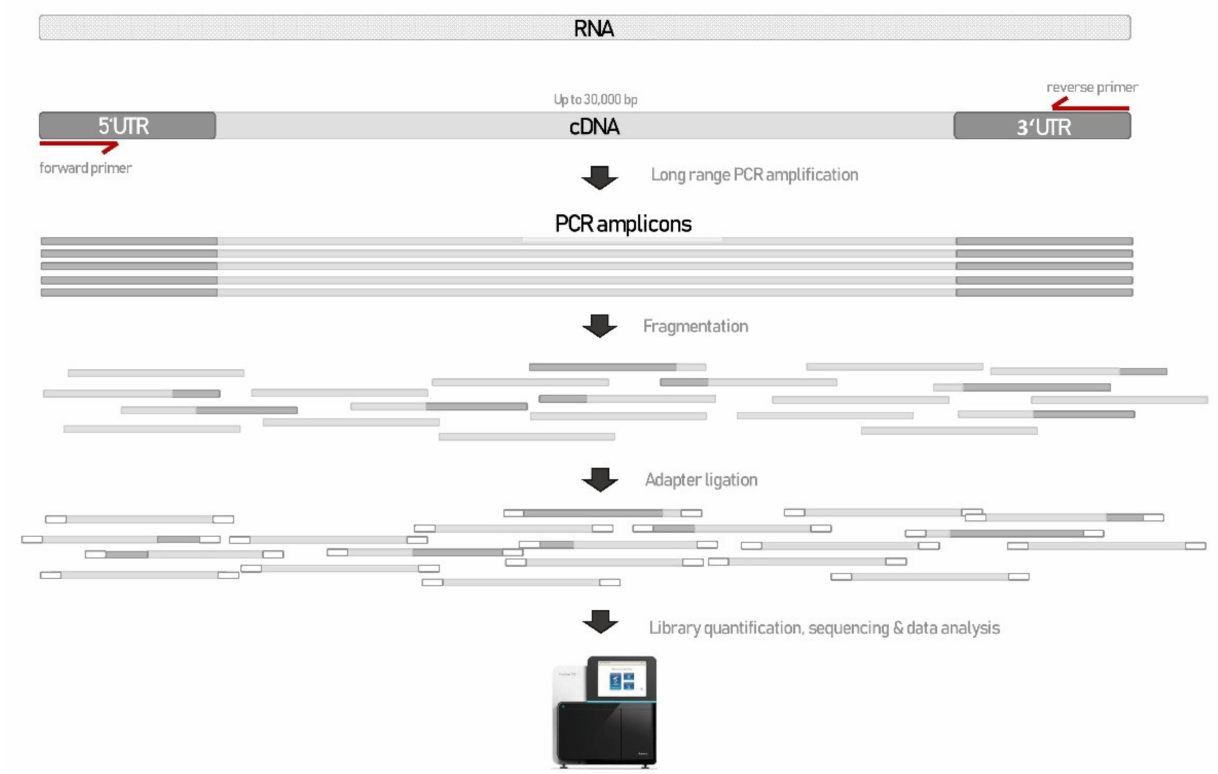
Figure 1. Schematic representation of novel approach used to detect splicing aberration with deep